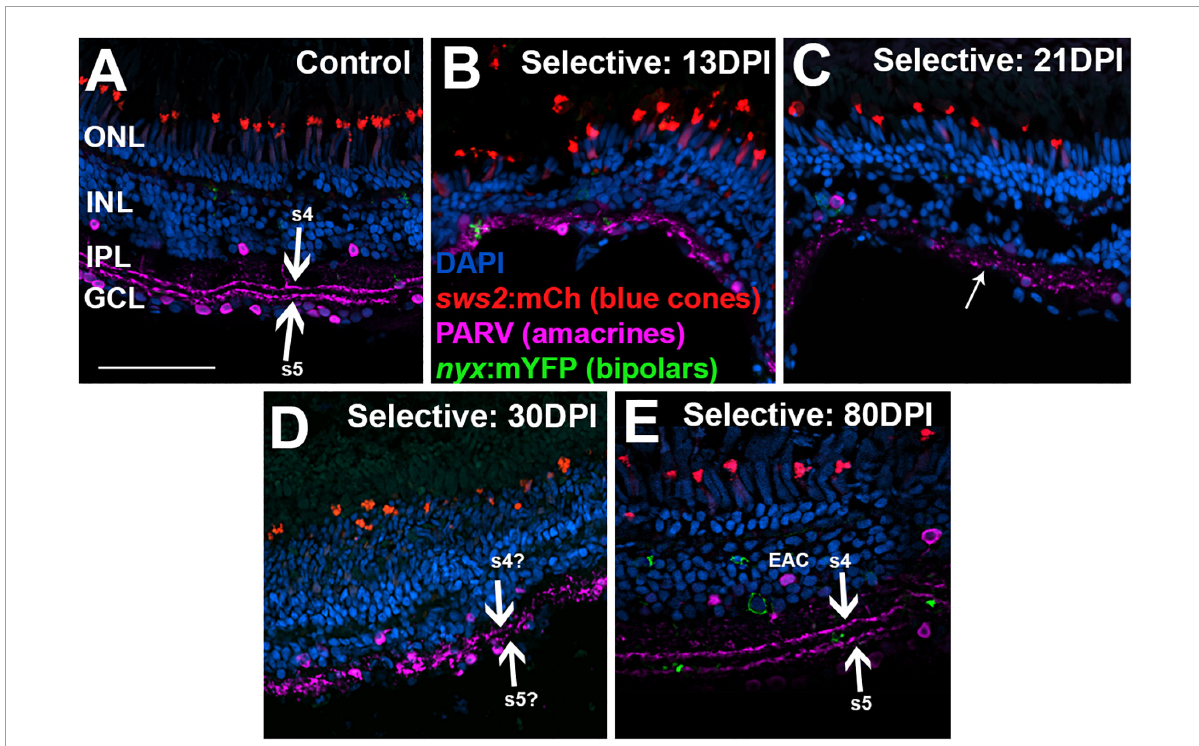
FIGURE11 Time-course of restoration of PARV + amacrine cells and their synaptic processes following selective lesion. Tissues were processed for indirect immunofluorescence and imaging after ERG recordings. Retinas were of zebrafish transgenic for sws2 :mCherry (in blue cones) and nyx :mYFP (in a subset of bipolar neurons); in this line the mYFP is expressed in a variegated manner (Schroeter et al., 2006), therefore not all of the panels in this figure show the YFP reporter. (A) Control retina displaying characteristic pattern of PARV + amacrine cells within the inner nuclear layer (INL) and ganglion cell layer (GCL), and stripes of processes occupying inner plexiform layer (IPL) sublaminae s4 and s5 (thick arrows), which receive input from ON-bipolar neurons. (B–E) Regenerating retinas at 13 (B) , 21 (C) , 30 (D) , and 80 days post-injury (DPI) (E) . PARV + sublaminae are not recognizable at 13 and 21 DPI; rather, the PARV + processes appear as disorganized puncta within the IPL (thinner arrow in C ). Hints of these layers emerge at 30 DPI (thick arrows in D ). At 80 DPI, the PARV + processes form two distinct stripes that may correspond with sublaminae s4 and s5 (thick arrows in E ). PARV + cell bodies are somewhat displaced from the boundary with the IPL (EAC in E , ectopic amacrine cell). ONL, outer nuclear layer; scale bar (in A , applies to all) = 50 µ